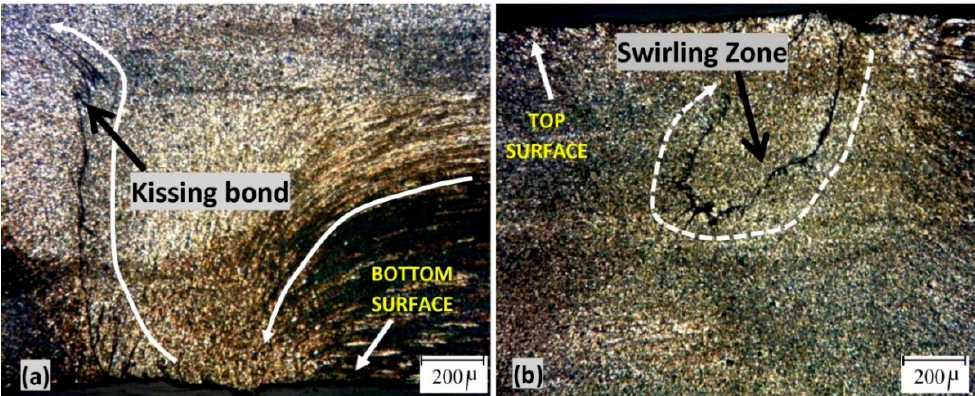
Figure 11. Formation of the flow-based defects at the structure of the FSW weld; ( a ) kissing bond by conical pin profile and ( b ) swirling zone by threaded pin profile, in speed sets of (250 mm/min and 1400 rpm).